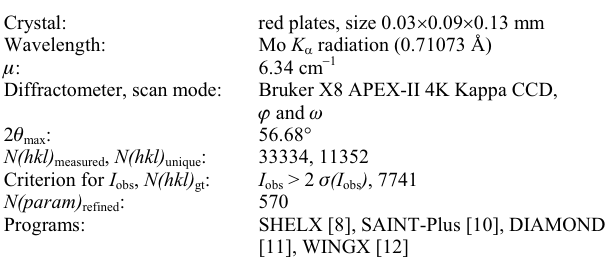
Table 1. Data collection and handling.